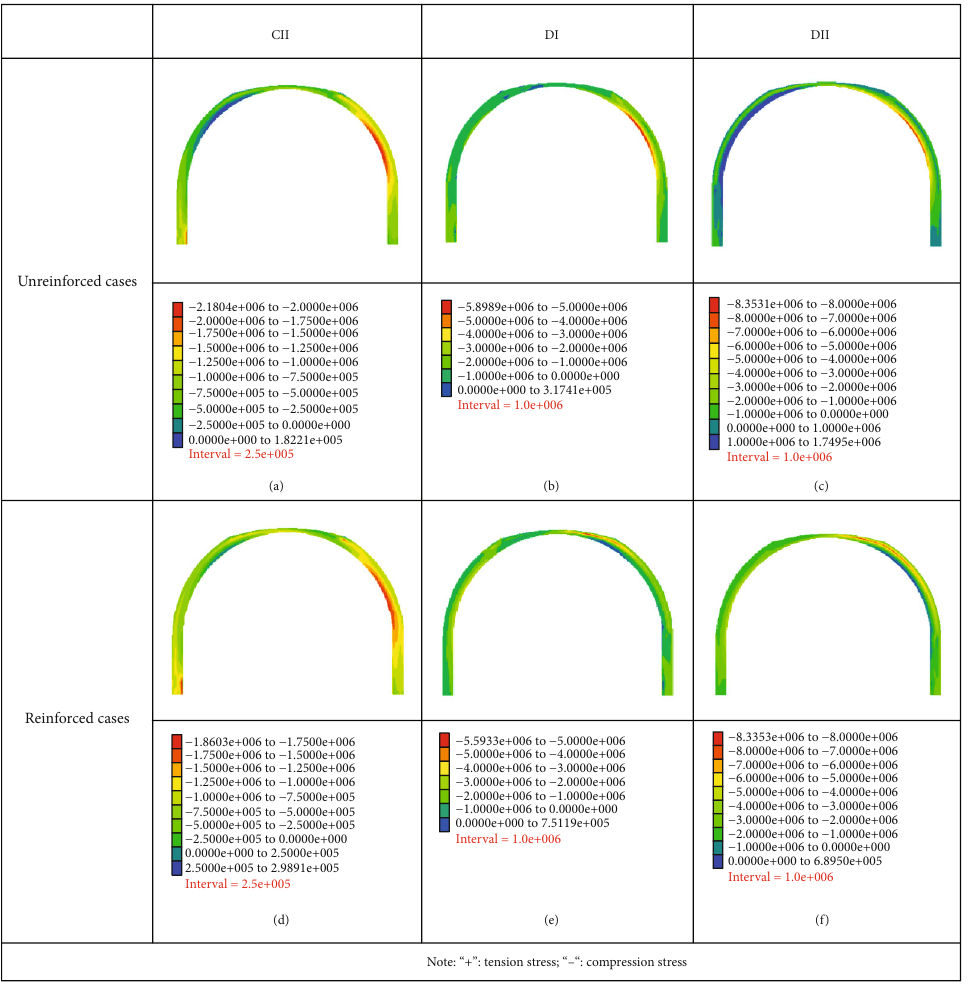
Figure 14: Axial stress distribution on lining concrete for tunnel with a cavity on the crown (unit: